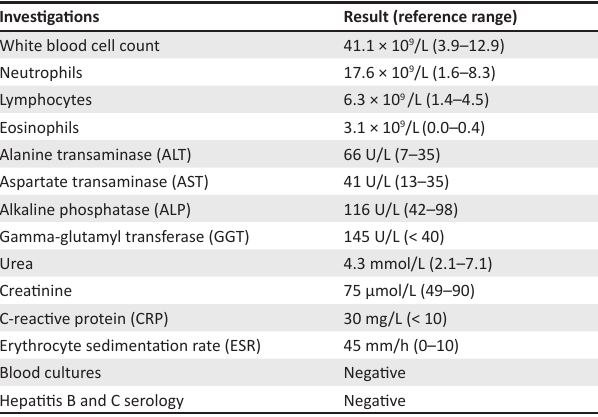
TABLE 1: Baseline laboratory investigations.